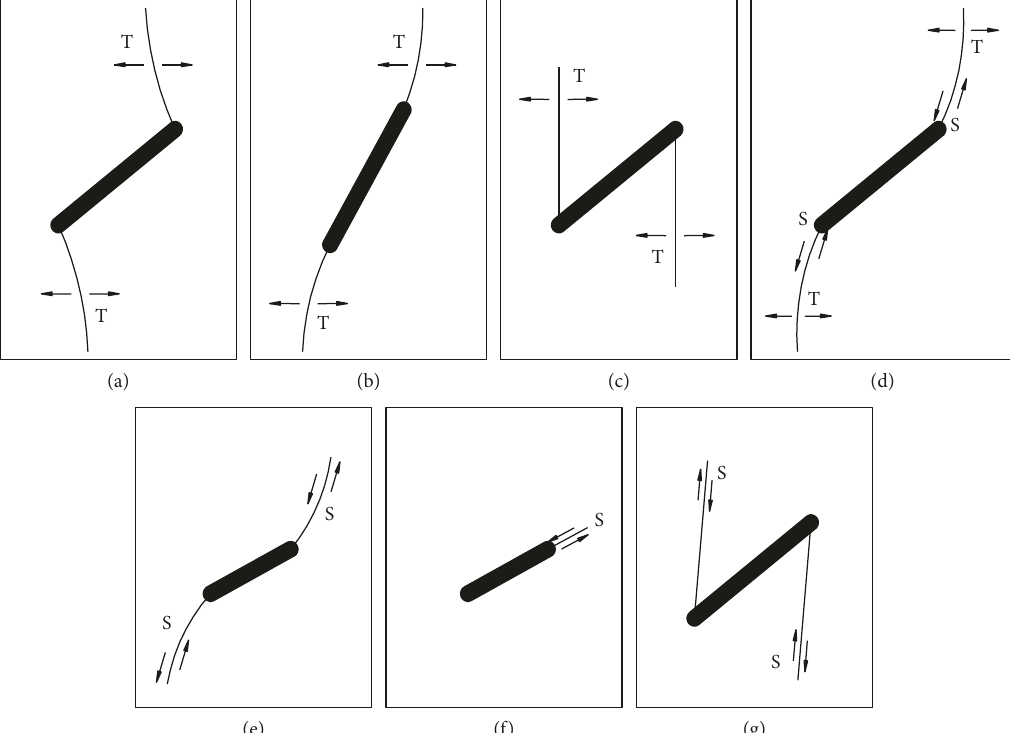
Figure 3: Various crack types initiated from the pre-existing flaw identified in the present studies (T � tensile cracking opening; S � shearing displacement) [21, 22]. (a–c) Tensile crack; (d) mixed tensile shear crack; (e–g) shear